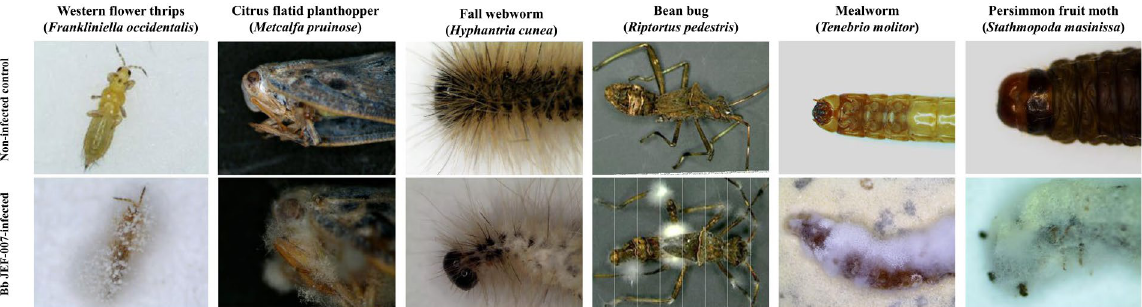
Figure 1. Insecticidal activity (virulence) of B . bassiana JEF-007 against western flower thrips, citrus flatid planthopper, fall webworm, bean bug, mealworm and persimmon fruit moth in laboratory conditions. The JEF-007 conidial suspension (1 × 10 7 conidia/ml) was sprayed on the adult, nymph or larva at 2 ml/dish, and the dishes were kept at 25 ± 1 °C (60% RH) for 7 ~ 10 days. The above photos were taken by the authors of this